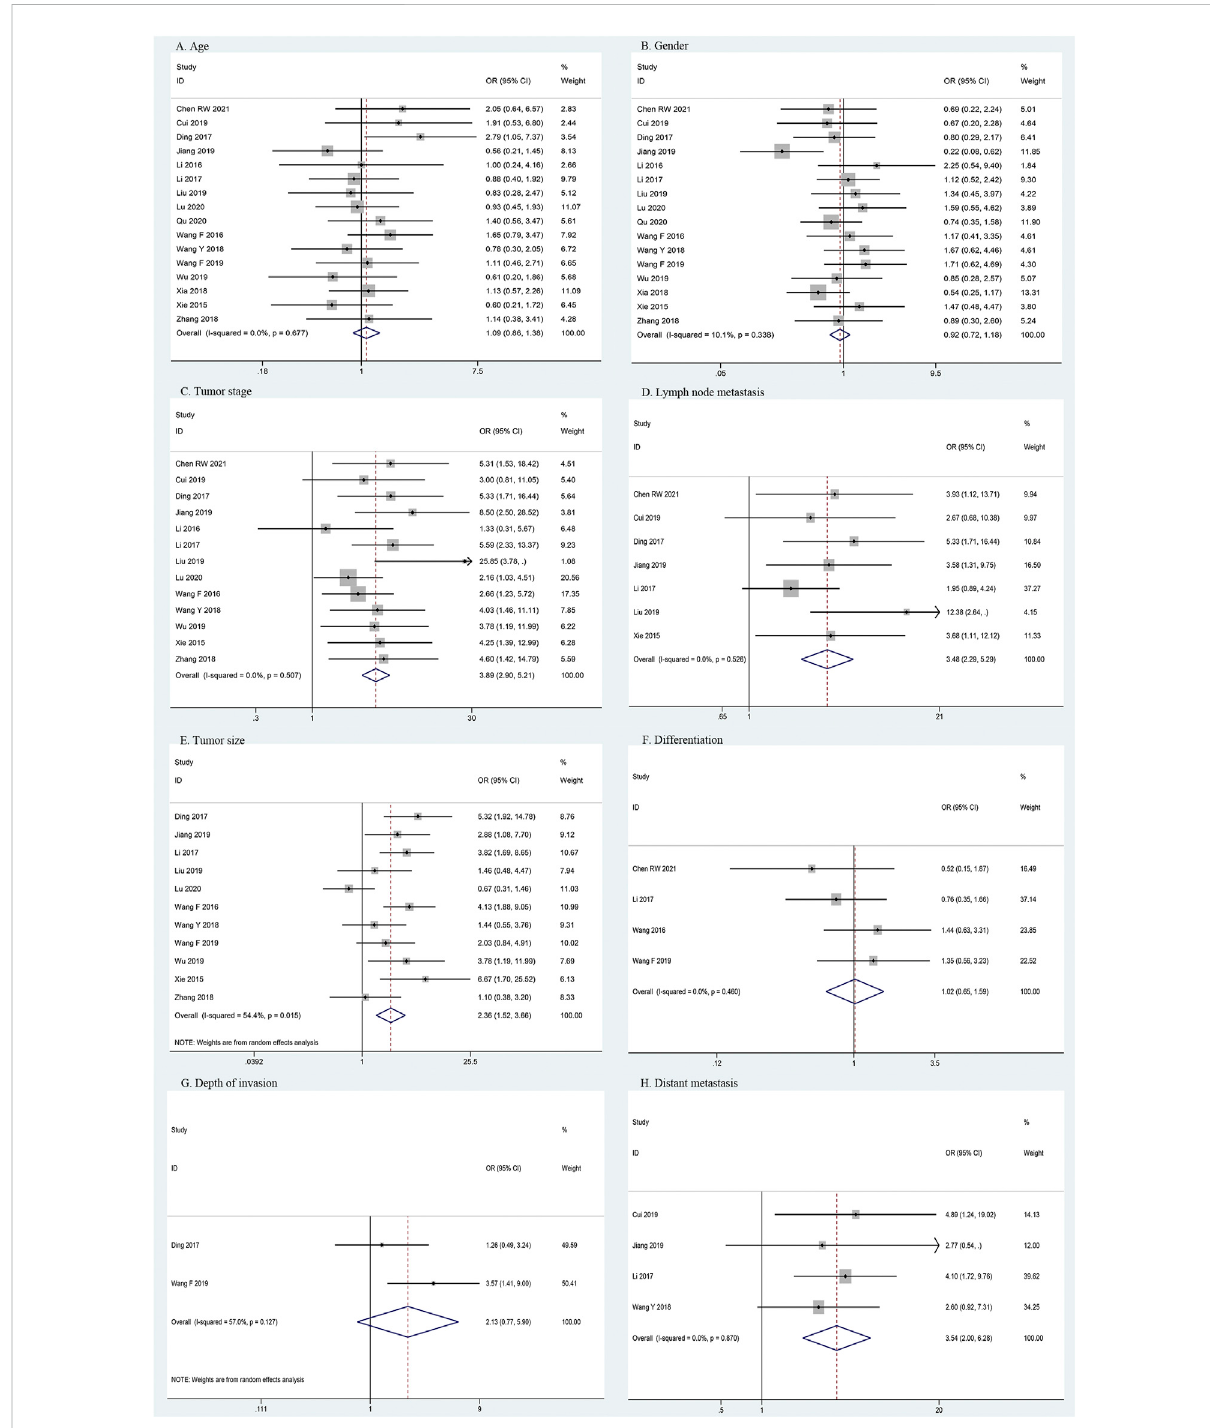
FIGURE 3 Forest plots for association of HOXA-AS2 expression with clinicopathological features. (A) Age. (B) Gender. (C) Tumor stage. (D) Lymph node metastasis. (E) Tumor size. (F) Differentiation. (G) Depth of invasion. (H) Distant